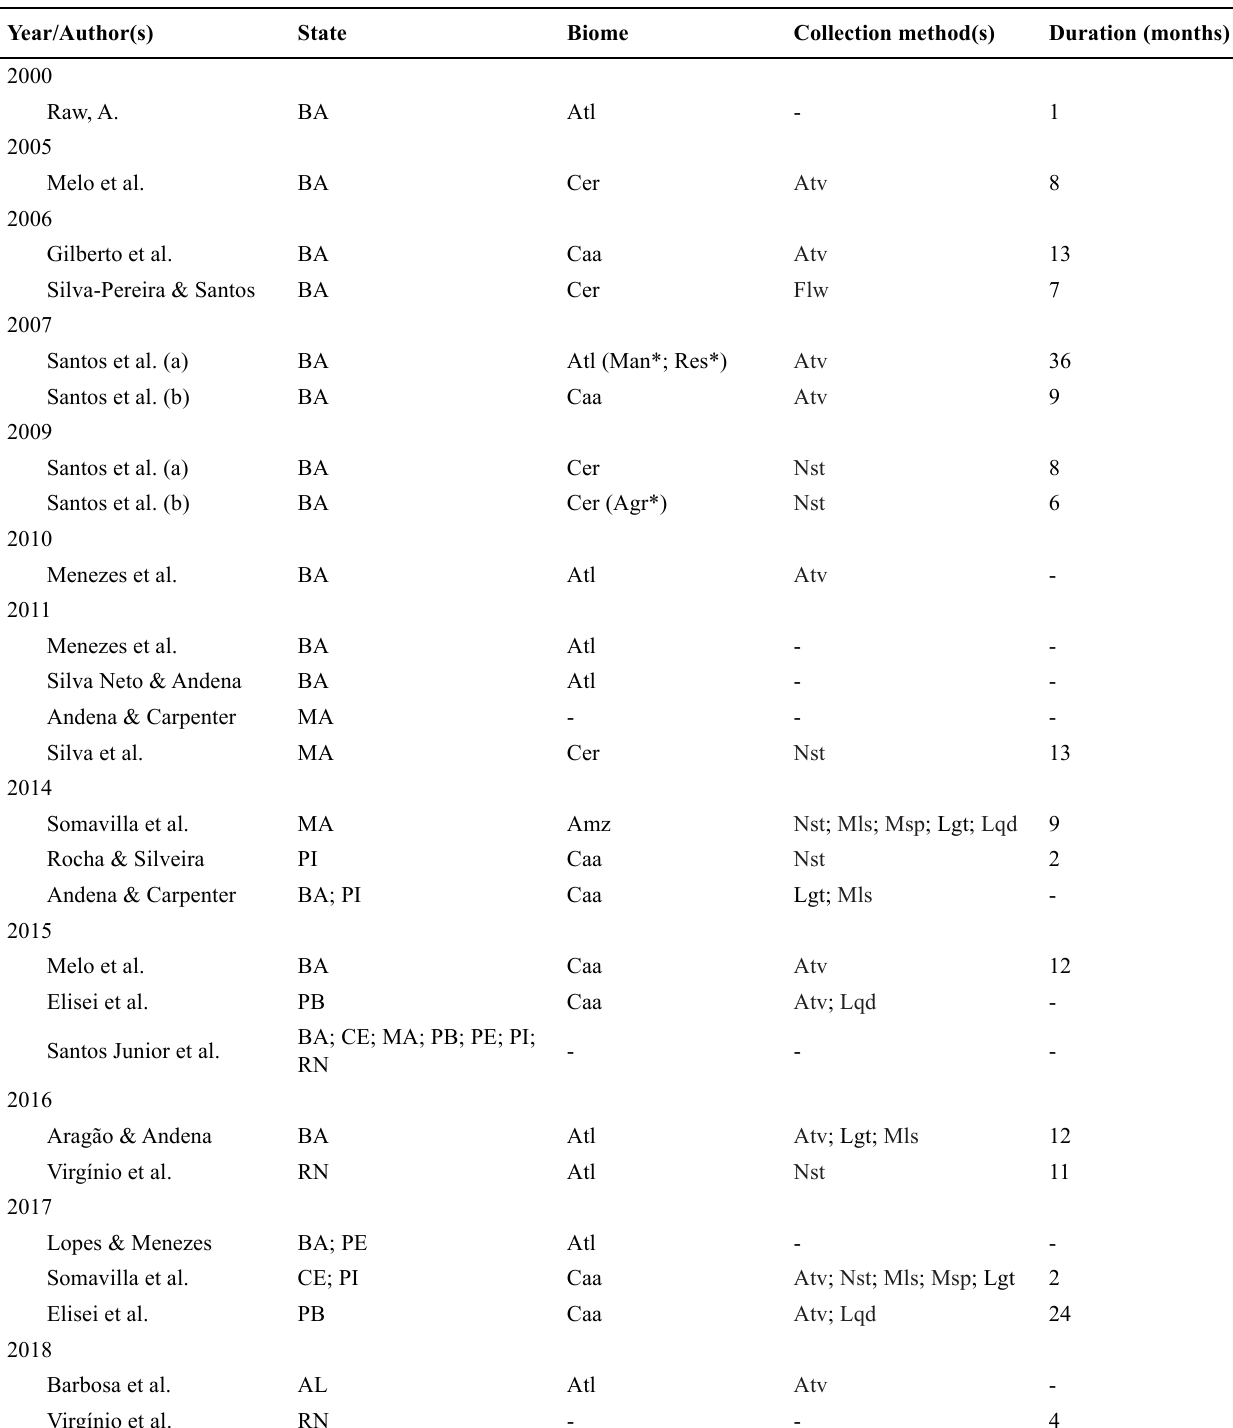
Table 1. Studies of social wasps in the Northeast region of Brazil from January 1979 to December 2019. - Data not available in publication; States: AL: Alagoas; BA: Bahia; CE: Ceará; MA: Maranhão, PB: Paraíba; PE: Pernambuco; PI: Piauí; RN: Rio Grande do Norte.